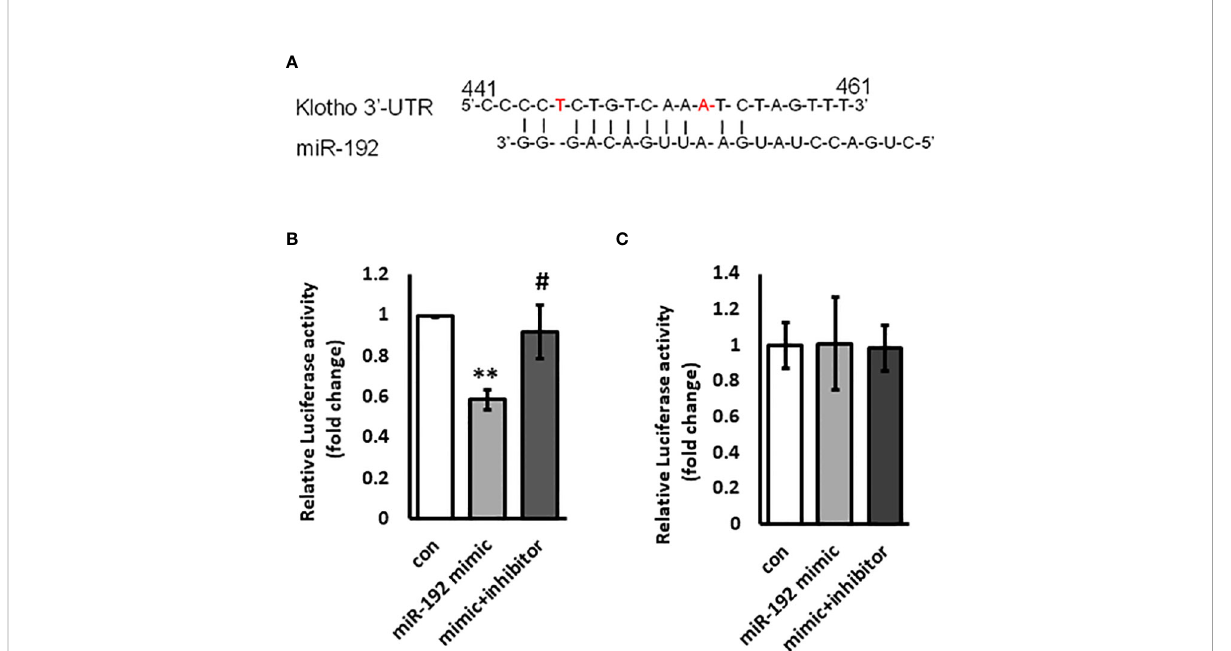
FIGURE 5 KL is a target gene of miR-192. Potential miR-192 binding site on the 3 ’ UTR of KL promoter is shown in (A) . miR-192 mimic or scrambled miRNA or the combination of miR-192 mimic and miR-192 inhibitor were co-transfected with kl-wt-luc 3 ’ UTR reporter (B) or kl-mut-luc 3 ’ UTR reporter (C) into HK2 cells for 72 hours and reporter activity was measured using Dual-Luciferase Reporter Assay kit. **p<0.01 and #p<0.05.